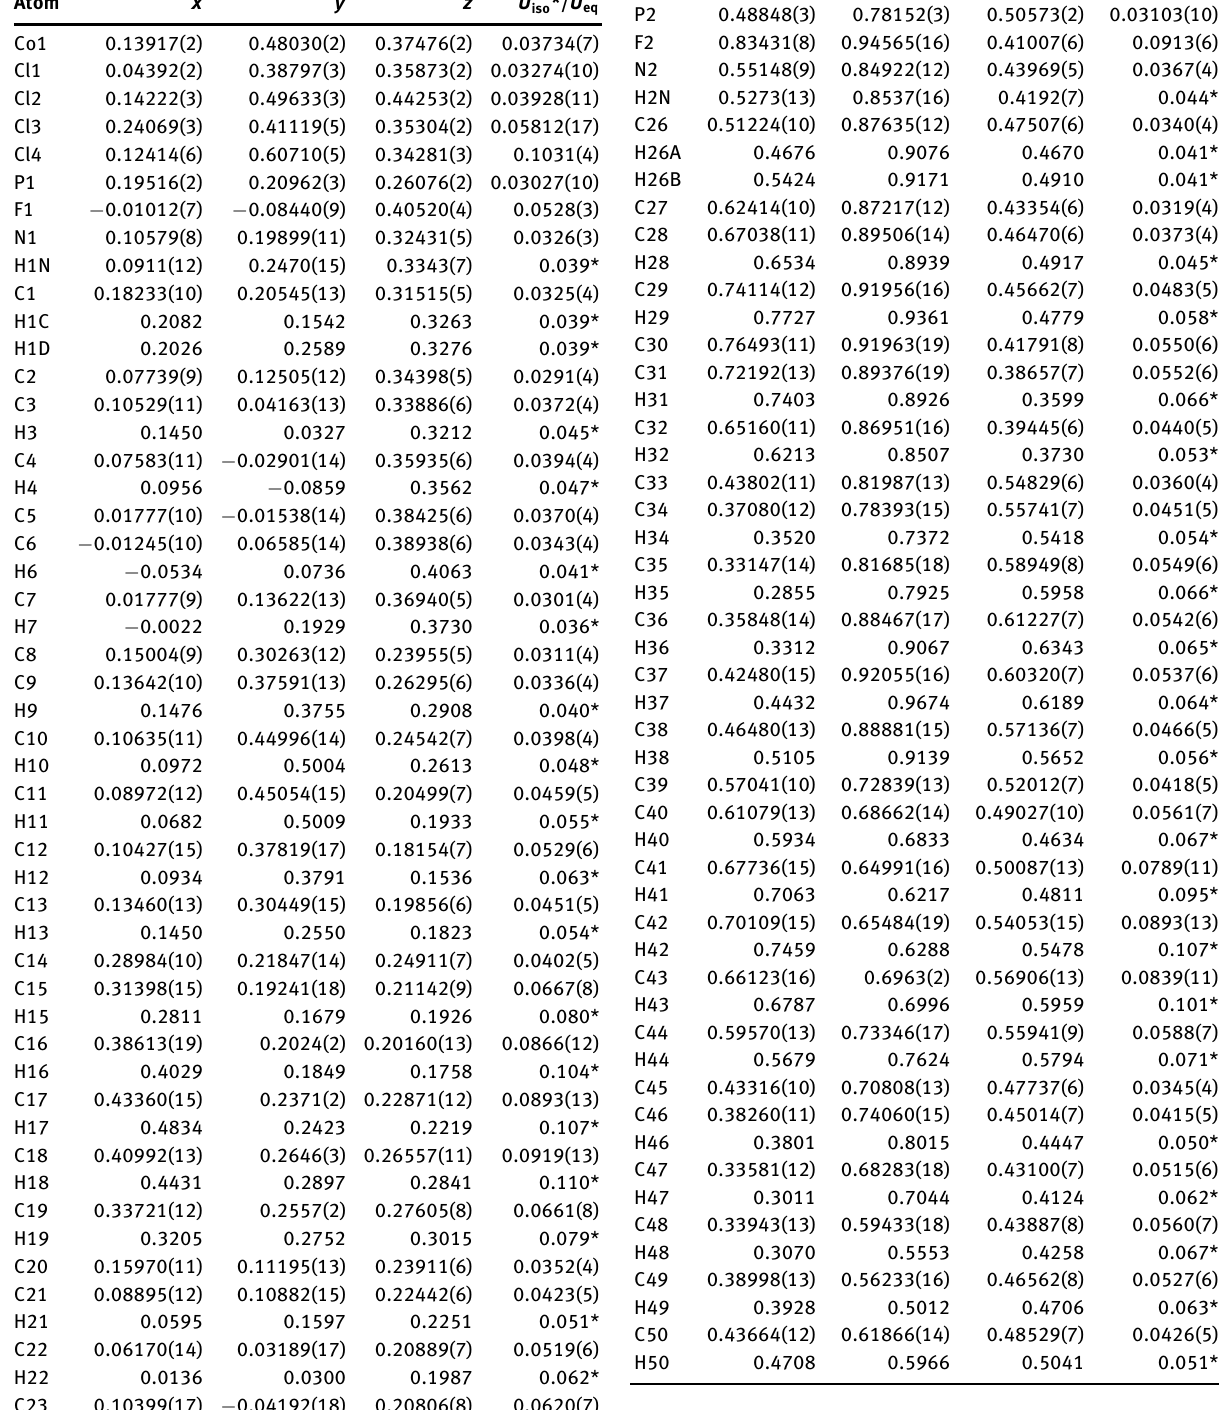
Table 2: Fractional atomic coordinates and isotropic or equivalent isotropic displacement parameters (Å 2